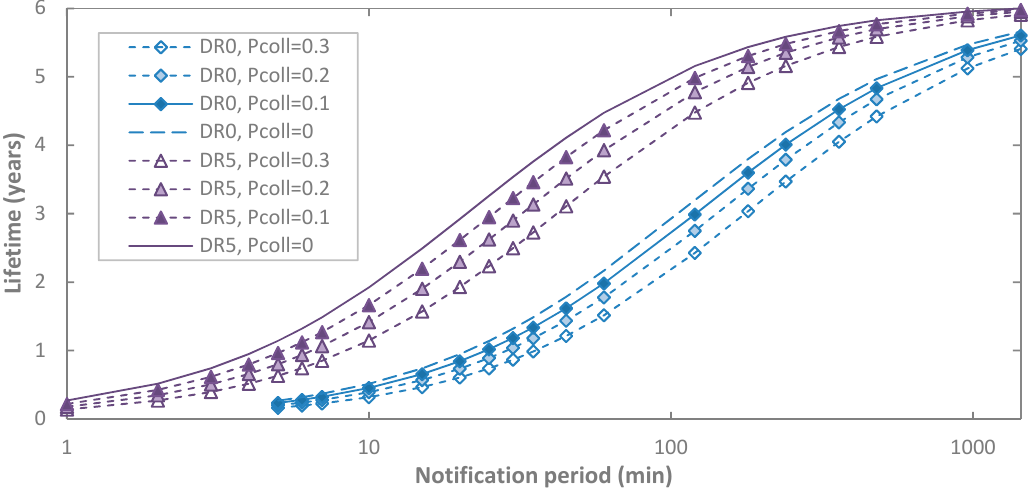
Figure 17. Impact of p coll on end-device lifetime in acknowledged transmission, as a function of T Notif , for different DR settings, and for BER = 0.